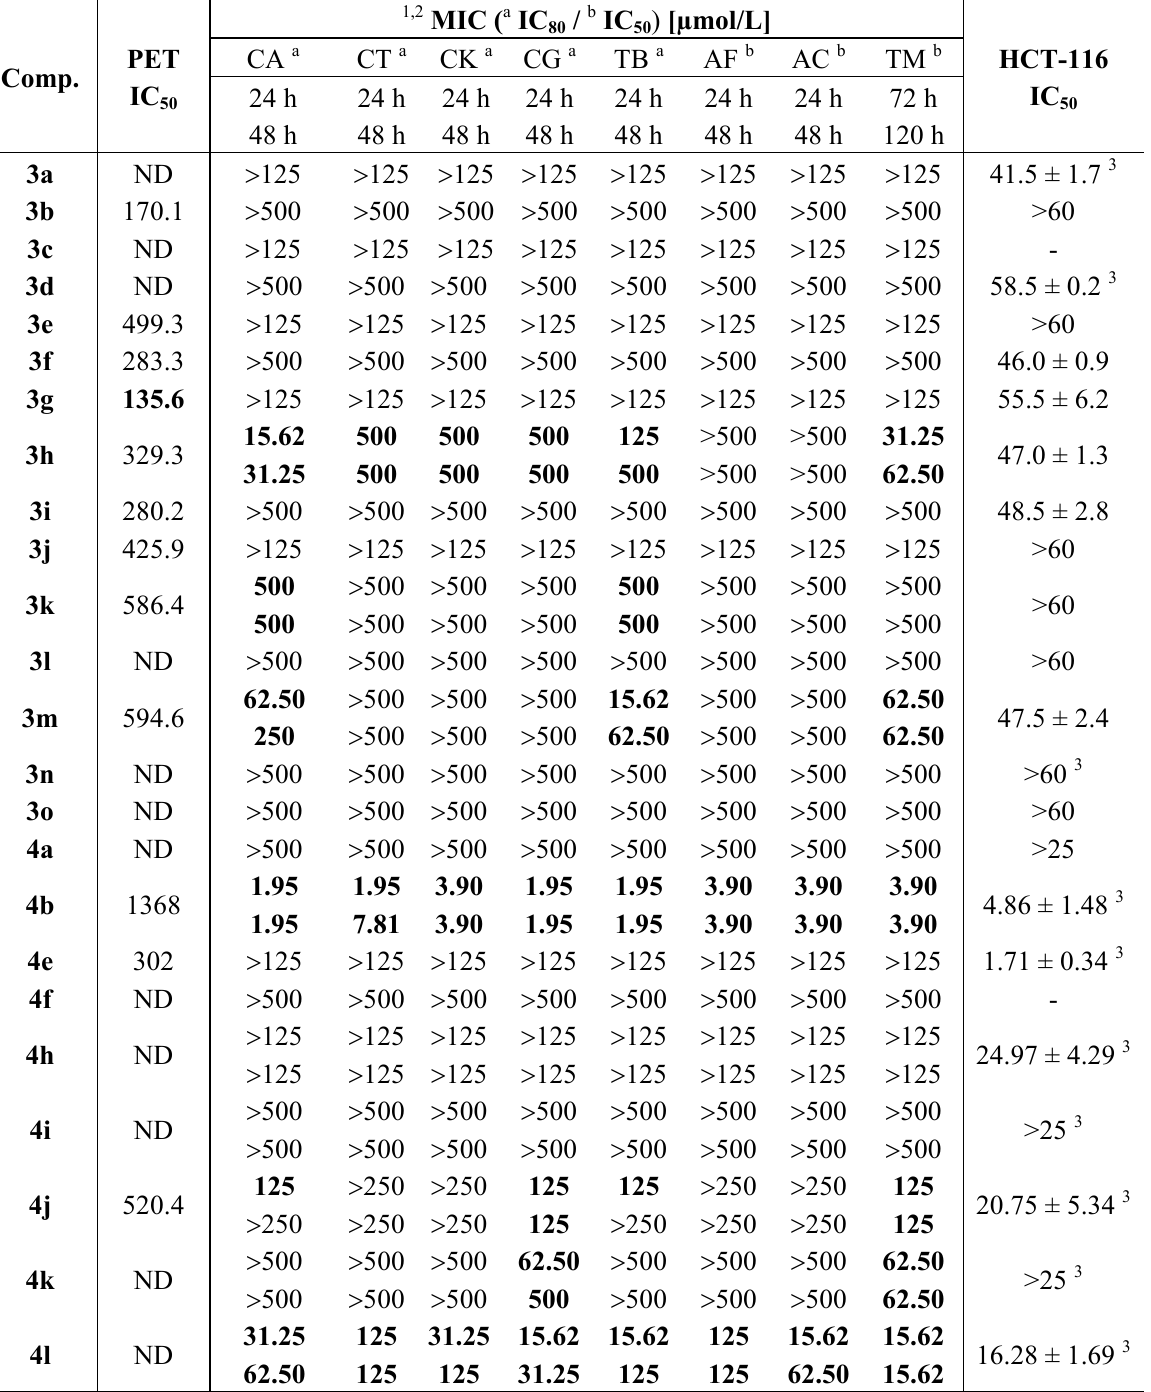
Table 3. IC [ μ mol/L] values related to PET inhibition in spinach chloroplasts of the 50 substituted thiosemicarbazones in comparison with 3-(3,4-dichlorophenyl)-1,1-dimethylurea (DCMU) as the standard; in vitro antifungal activity (IC compared to fluconazole (FLU) as the standard; in vitro antiproliferative activity IC [ μ mol/L] of compounds compared to doxorubicin as the standard. ND = not determined due to precipitation during the experiment or interaction with 2,6-dichlorophenol- indophenol